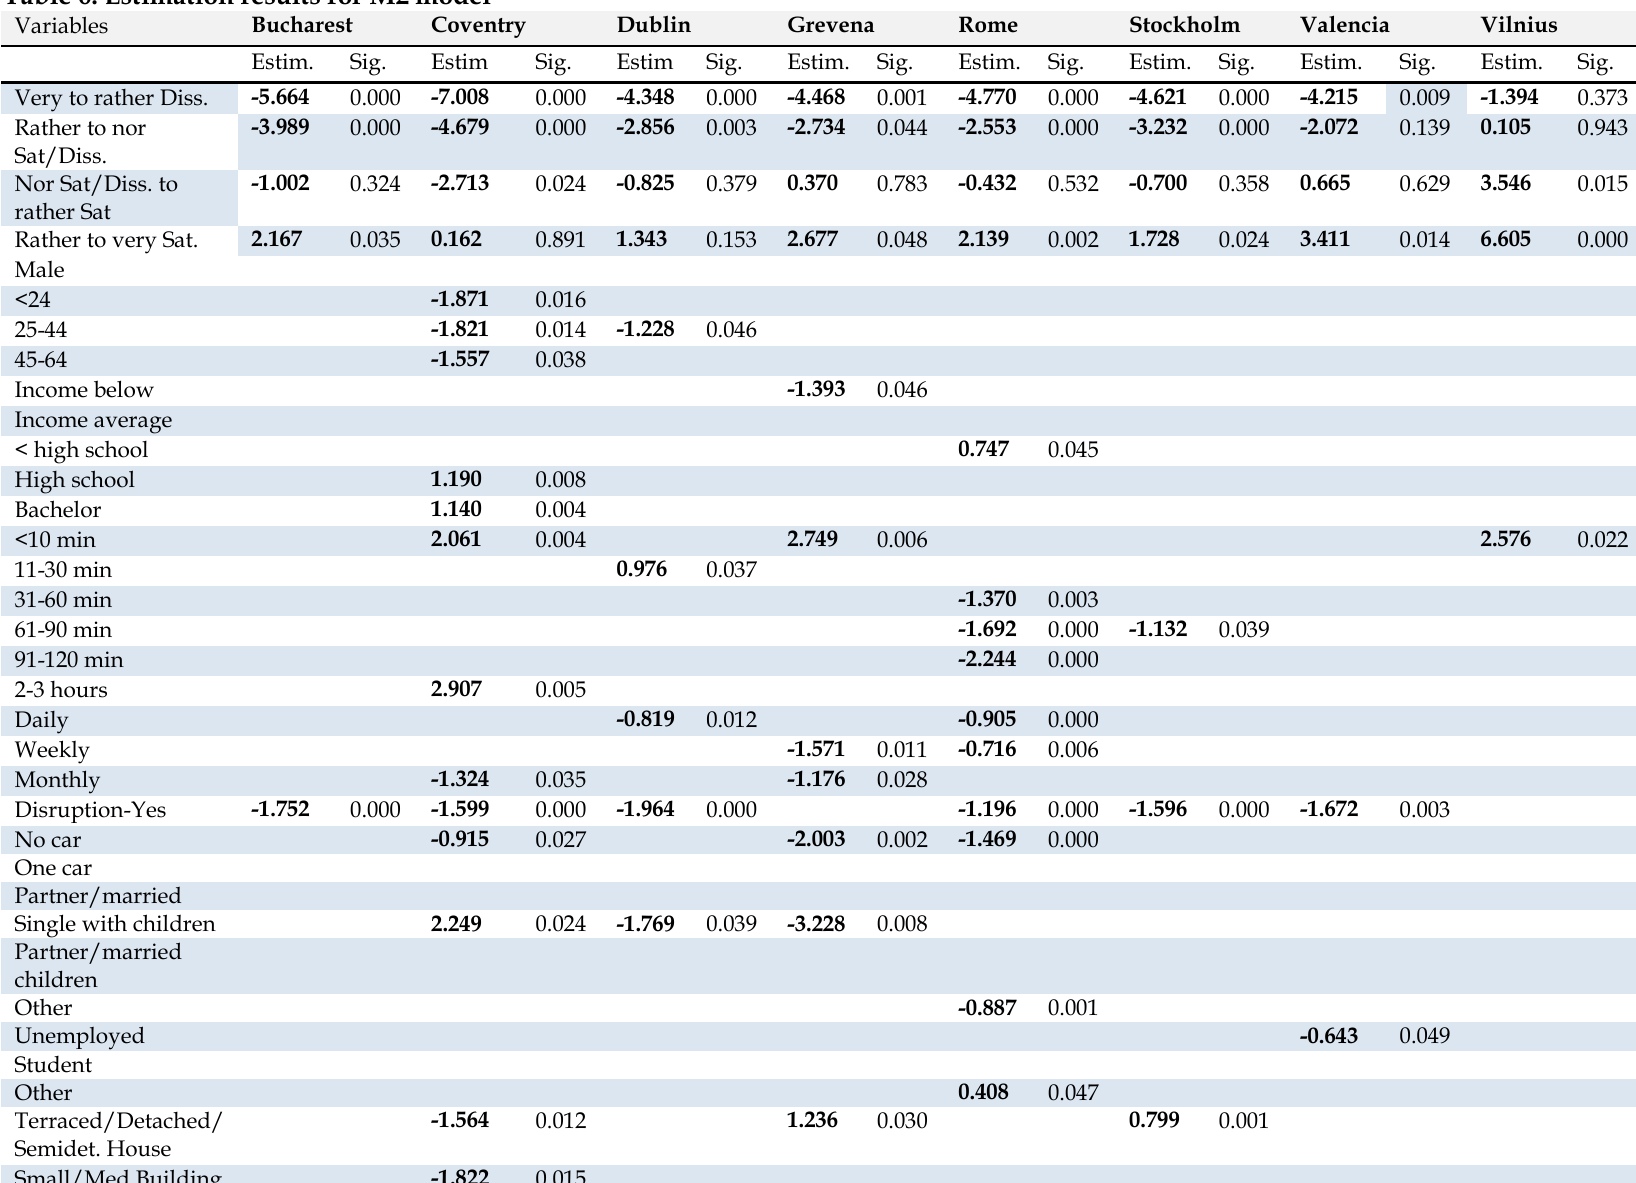
Table 6: Estimation results for M2 model